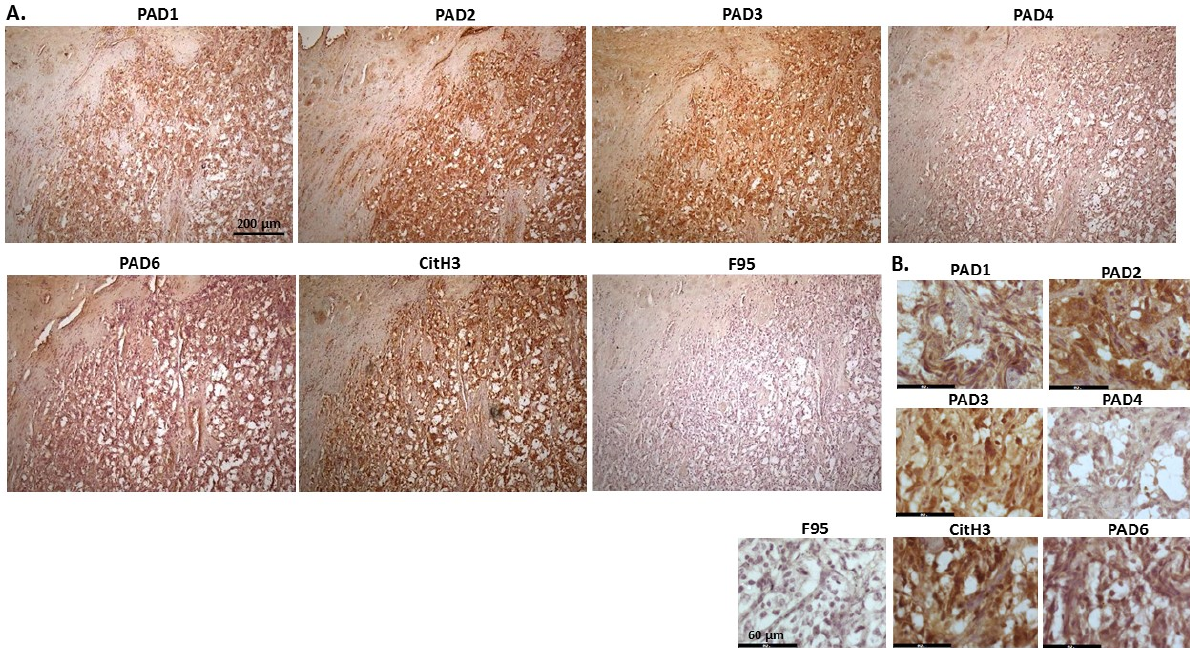
Figure 14. Cow, tumour metastasis to the heart. Origin of the tumour is uncertain but can be from chemoreceptors at the carotid or aortic body, from C-cells in the thyroid gland (ultimobranchial tumour or adrenal gland medulla), possible pheochromocytoma—neuroendocrine tumour. ( A ) Overview images for PAD1, 2, 3, 4, 6, CitH3 and F95 stainings of serial tissue sections; scale bar represents 200 μ m for all images; 10× objective. ( B ) Higher magnification shown for each staining from the images in ( A ); scale bar represents 60 μ m for all images; 40× objective.